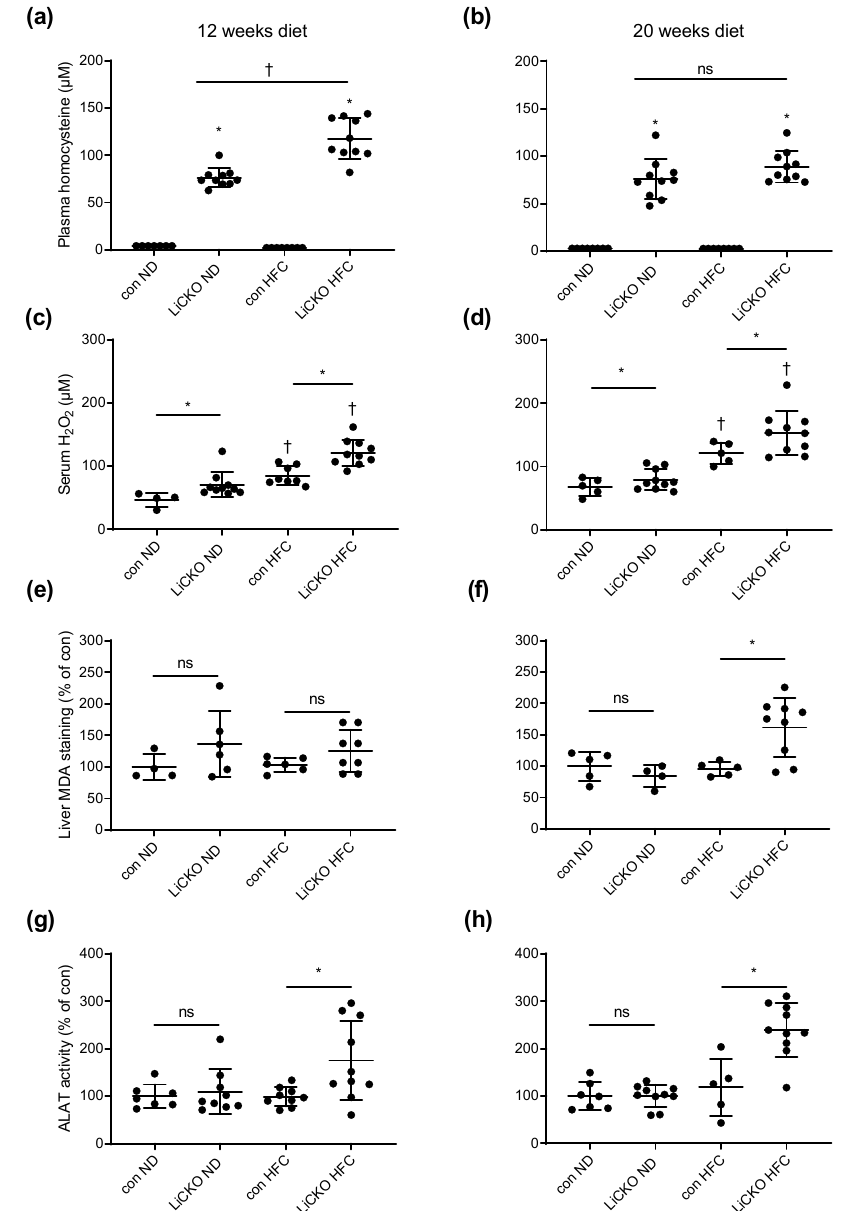
Figure 3. Plasma homocysteine, serum hydrogen peroxide, liver MDA staining, and plasma ALAT. ( a ) At 12 weeks of diet, homocysteine was elevated in plasma of ND-fed LiCKO mice and further significantly increased in LiCKO HFC mice; ( b ) At 20 weeks of diet, plasma homocysteine was similarly elevated in both LiCKO ND and LiCKO HFC; ( c , d ) At 12 and 20 weeks of diet, two-way ANOVA indicated that genotype (LiCKO) and diet (HFC) were both associated with further increased serum H 2 O 2 concentrations; ( e ) No differences in liver MDA staining were observed between groups at 12 weeks of diet; ( f ) At 20 weeks of diet, liver MDA staining was significantly increased only in LiCKO HFC; ( g , h ) At 12 and 20 weeks, plasma ALAT activity was increased in LiCKO HFC over con HFC. * p < 0.05 difference between con and LiCKO on same diet; † p < 0.05 difference between ND and HFC for con or LiCKO; ns = non-significant.